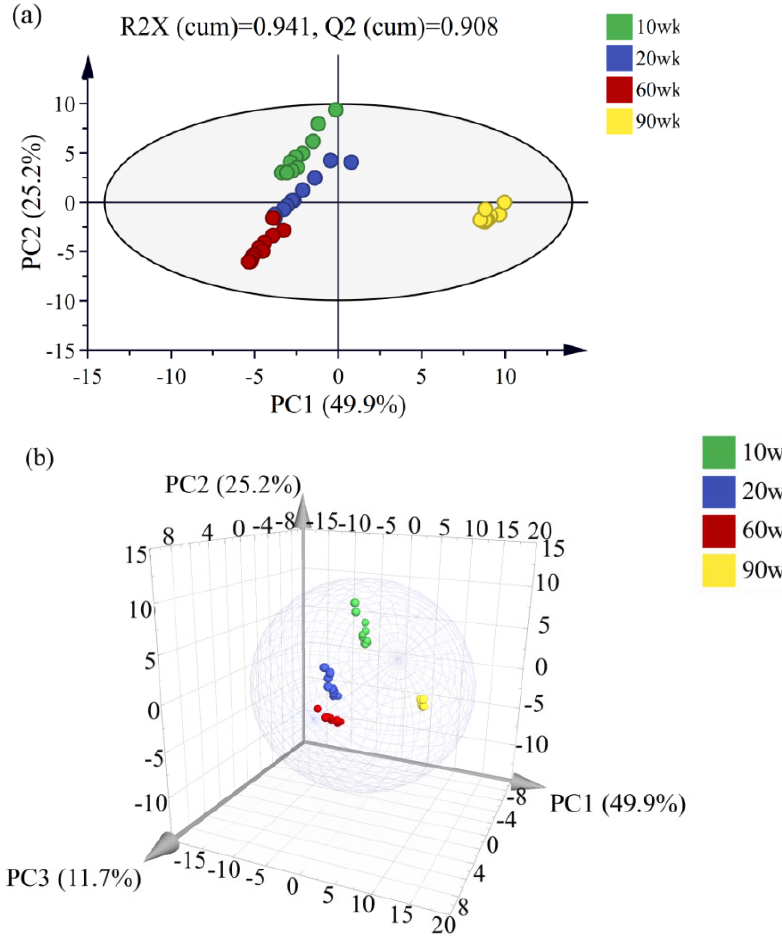
Figure 3. Principal component analysis of four soup samples (2D ( a ) and 3D ( b ) plots).